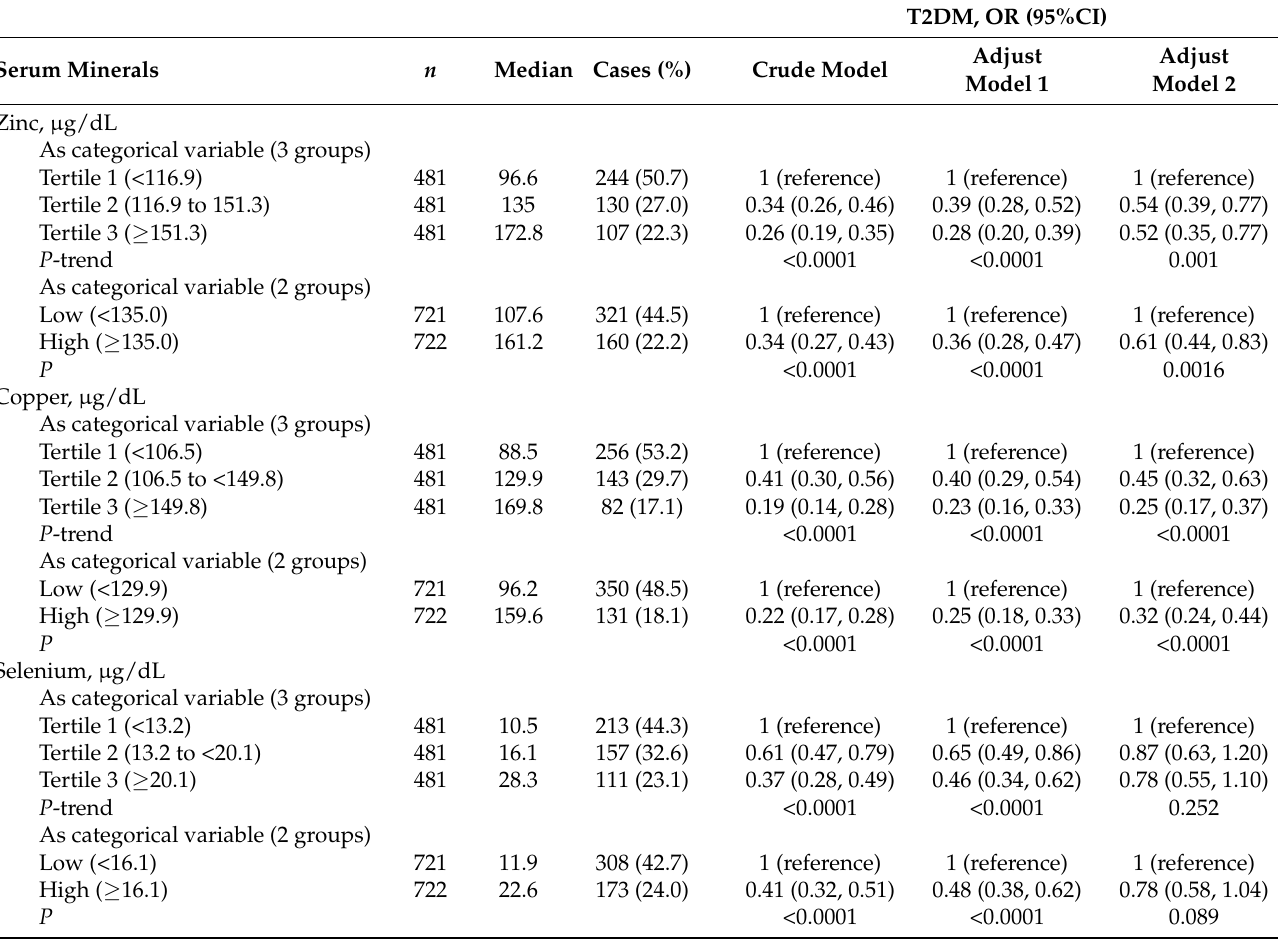
Table 2. Independent associations between serum zinc, copper and selenium levels and